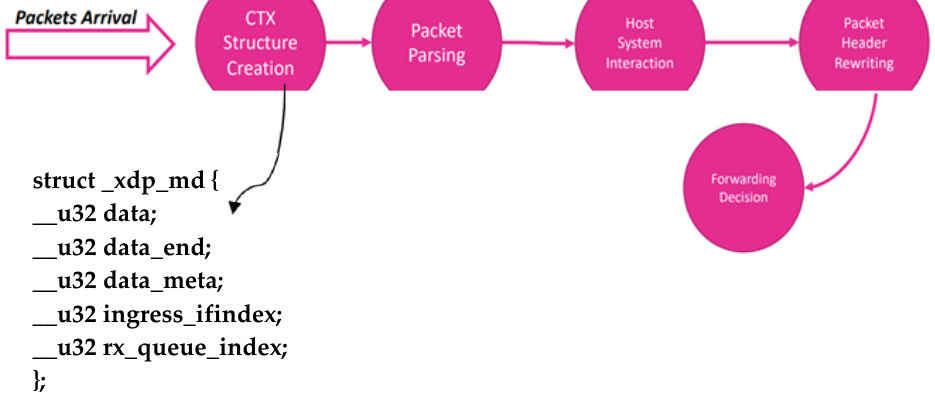
Figure 4. hXdp hardware design of logic architecture. The four extended eBPF instructions that make up a VLIW instruction are read at processor start-up and their appropriate execution lanes are statically assigned [27]. The operations are downloaded in the background from the register file at this point, as four execution lanes work simultaneously to complete the final three pipeline steps. In case there is a need of eBPF instructions to load in memory, locations are pre-fetched during ID, and consuming the pre-defined values, the appropriate subunit is activated during IE. These include the control unit, memory unit (MU), and arithmetic and logical unit. Utiliz-